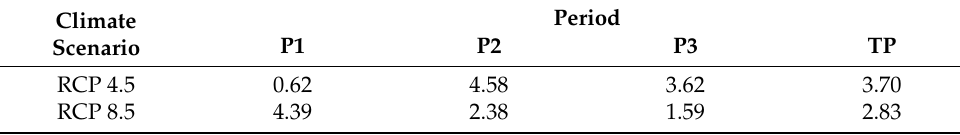
Figure 5. Hydrologic risks for the RCP 4.5 (HadGEM2-ES). Table 5. Result of the average risk increase rate